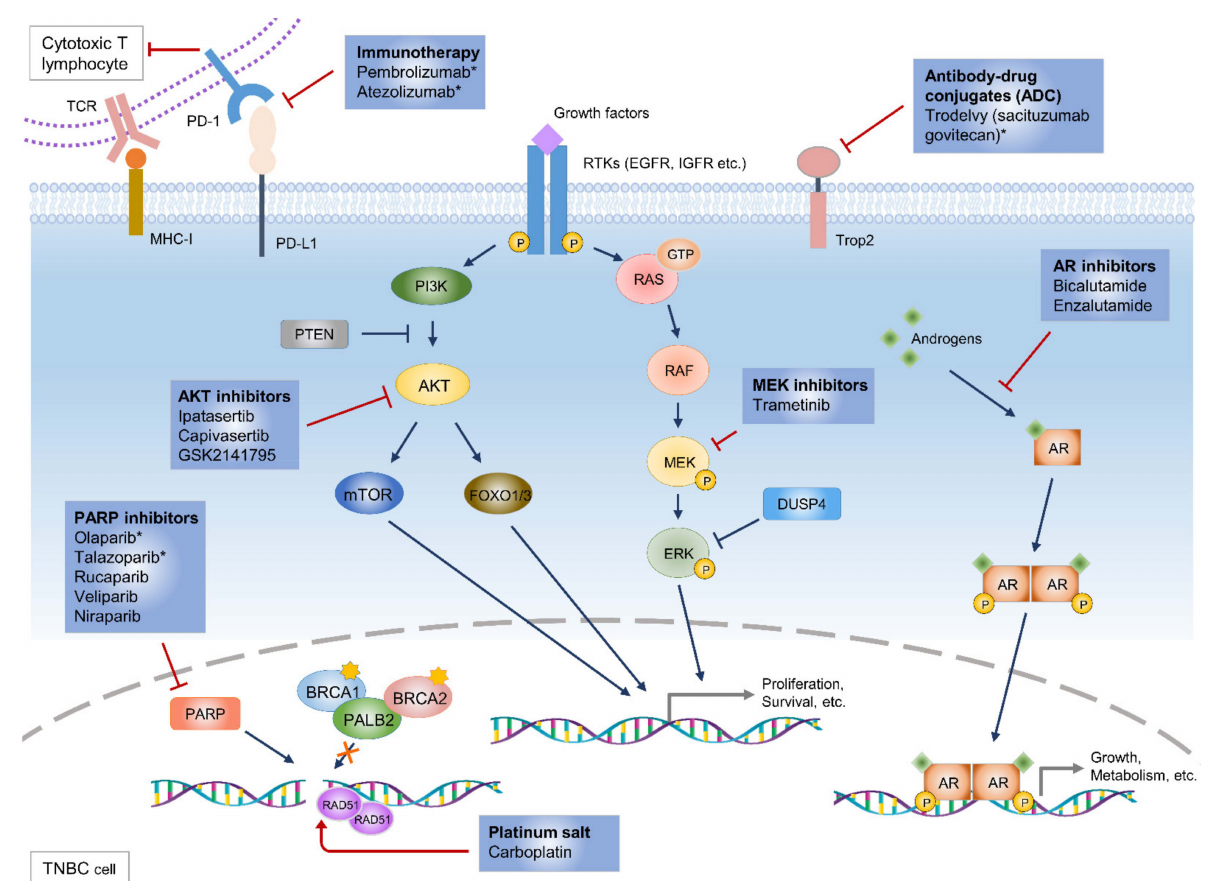
Figure 1. Scheme of potential molecular targets and therapeutic agents including FDA-approved and upcoming targeted therapies in TNBC. Extracellular stimuli, such as growth factors, initiate PI3K/AKT and RAS/MAPK signaling pathways to activate transcription of target genes involved in proliferation, survival, and tumorigenesis. There are potential targeted therapeutics that inhibit these pathways, including AKT inhibitors or MEK inhibitors. In the case of TNBC tumors harboring BRCA1/2 mutations, PARP replaces them, allowing DNA damage to repair and tumor cells to survive. Thus, PARP inhibitors are commonly prescribed for BRCA1/2 mutated TNBC patients. Carboplatin, a platinum salt, induces DNA crosslink strand breaks and causes the apoptosis of tumor cells with a dysfunctional repair pathway. Androgen receptor (AR) is activated by binding of androgen, triggering dimerization and translocation of androgen-AR complex to stimulate cell growth and metabolism in TNBC. AR inhibitors compete with androgens to bind AR and block the AR signaling pathway. Cytotoxic T-lymphocytes recognize the neo-antigen of tumor cells binding to major histocompatibility complex (MHC)-I and kill the tumor cells. To avoid anti-cancer immunity of cytotoxic T-lymphocytes, TNBC tumor cells exhibit anti-programmed death ligand 1 (PD-L1), which binds to PD-1 of the T-lymphocyte. Immunotherapeutic antibodies have been introduced to suppress immune evasion in TNBC tumors. Recently, antibody-drug conjugates (ADC) have been approved by the FDA for clinical use in TNBC. Blue arrow: signaling transduction, red arrow: action of blockers and inhibitors, yellow star: mutations, yellow circle: phosphorylation, orange circle: neo-antigen peptide, *: U.S. Food and Drug Administration (FDA)-approved